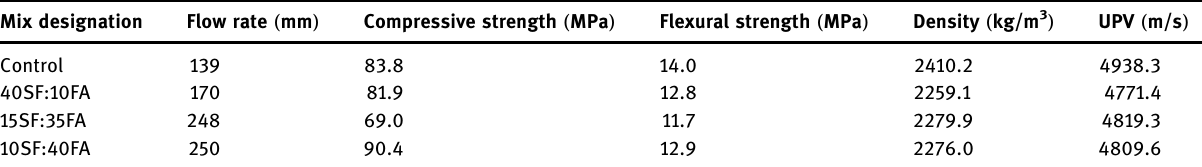
Table 4: The result values of all executed tests